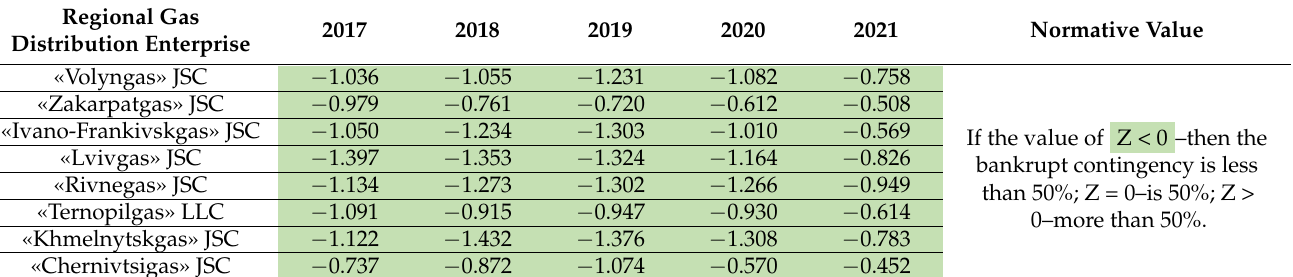
Table 2. Altman’s two-factor model